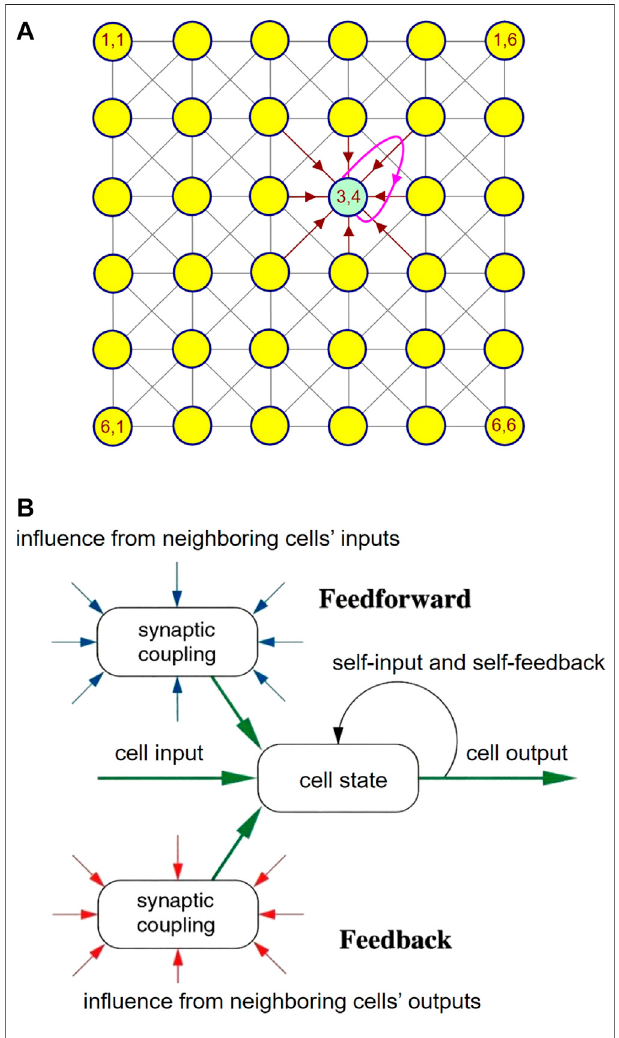
FIGURE1|(A) Physicalconnectivityamongthelocallycoupledcellsofa two-dimensional CNN with six rows and six columns. (B) Schematic illustration of the main features of a CNN cell, revealing some of its analogies with a biological neuron, which explains the nomenclature originally introducedtocharacterizethelocallycouplednonlineardynamicarray,namely Cellular Neural Network